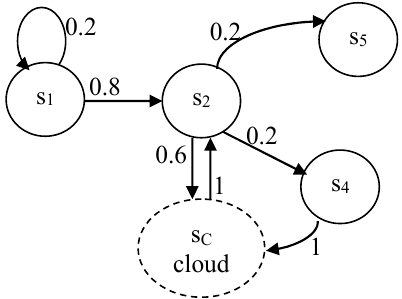
Figure 4. Markov model of “cloud” PDP (model “C”).